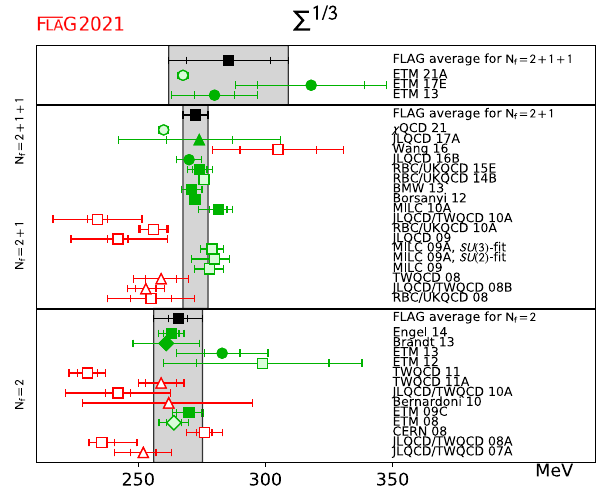
(cid:17)¯ uu (cid:18) in the MS-scheme, at the renormalization scale μ = 2GeV. Square Fig. 14 Cubic root of the SU ( 2 ) quark condensate (cid:13) ≡ − lim m u , m d → 0 symbols indicate determinations from correlators in the p -regime, up triangles refer to extractions from the topological susceptibility, diamonds to determinations from the pion form factor, and bullet points refer to the spectral density method